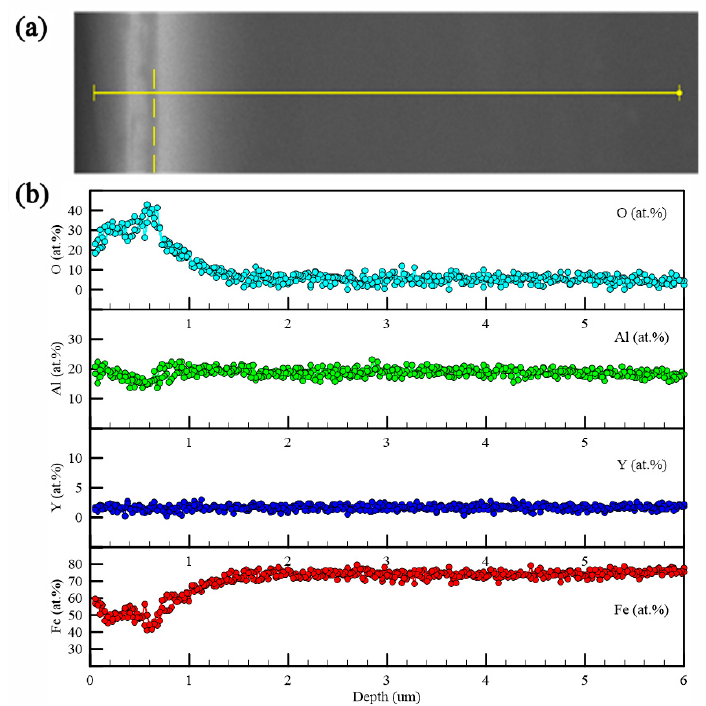
Figure 9. SEM-EDS analysis of the oxide layer formed during fatigue testing at 800 °C on the surface of the flat dog-bone specimen: ( a ) SEM micrograph of the sample with line analysis (solid line). The dashed line indicates the edge of the sample. ( b ) Plot of the concentration profiles for O, Al, Y, and Fe.